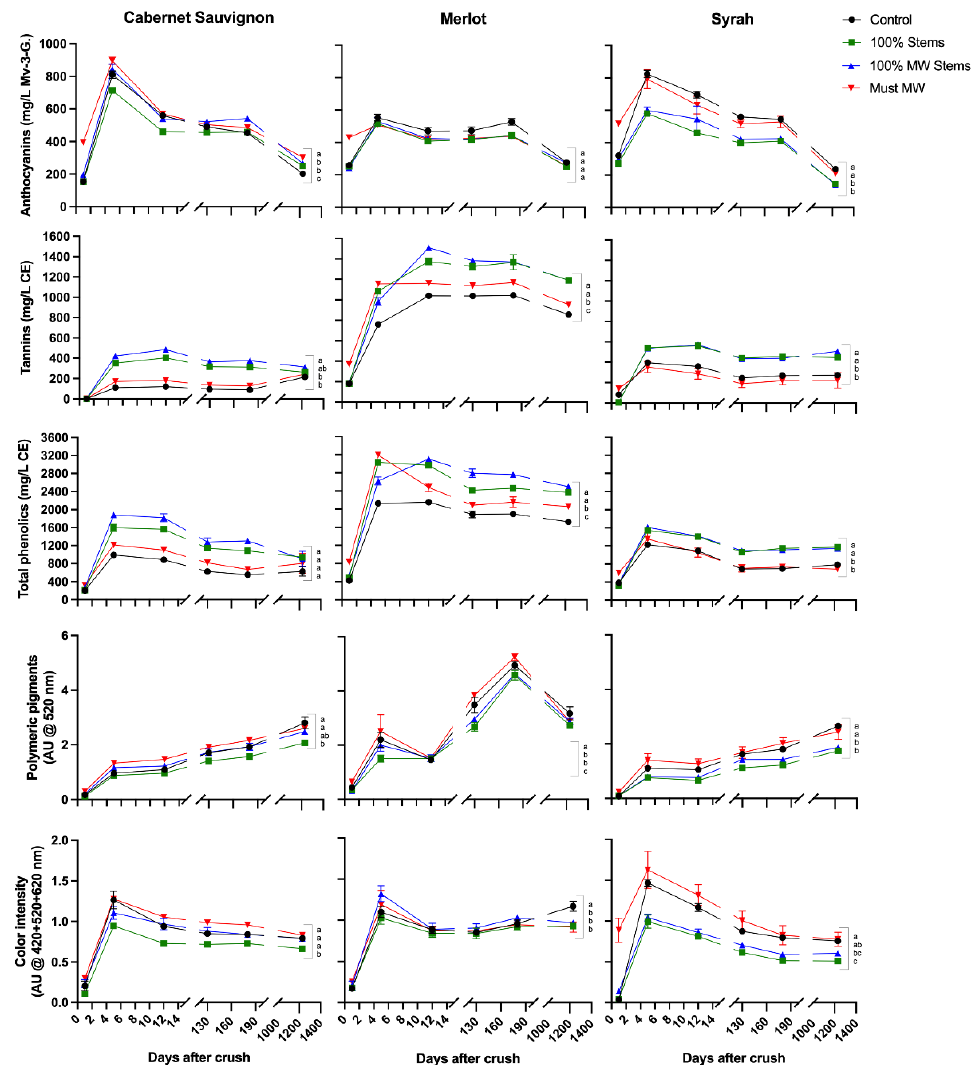
Figure 3. Evolution during winemaking, early and extended bottle aging of selected phenolic classes and wine color in the wines of the 2017 vintage. Different letters in the last sampling point (12 months of bottle aging), indicate significant differences for Fisher’s LSD test and p < 0.05. Mv-3-G.: malvidin-3-glucoside equivalents; AU: absorbance units; CE: catechin-equivalents.